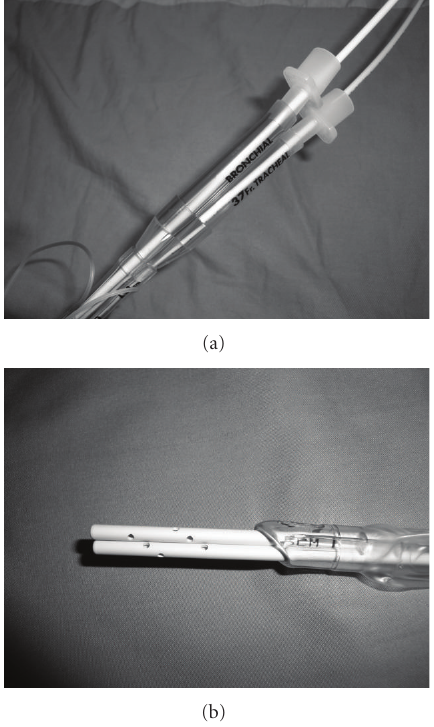
Figure 4: (a) Two AECs used—one inserted into each lumen of the DLT. (b) The combined OD of the 2 AECs is relatively large compared to the ID of the SLT and helps reduce the protrusion of the tip of the